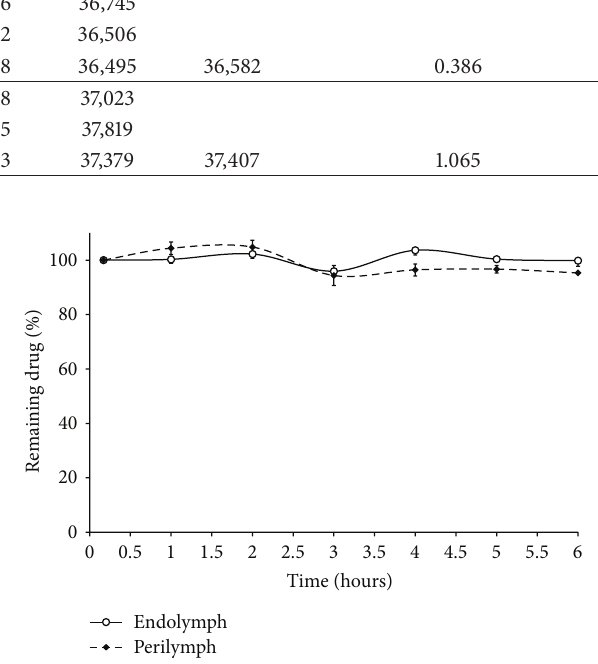
Figure 4: Stability of FUR in simulated cochlear fluid ( 𝑛 = 3